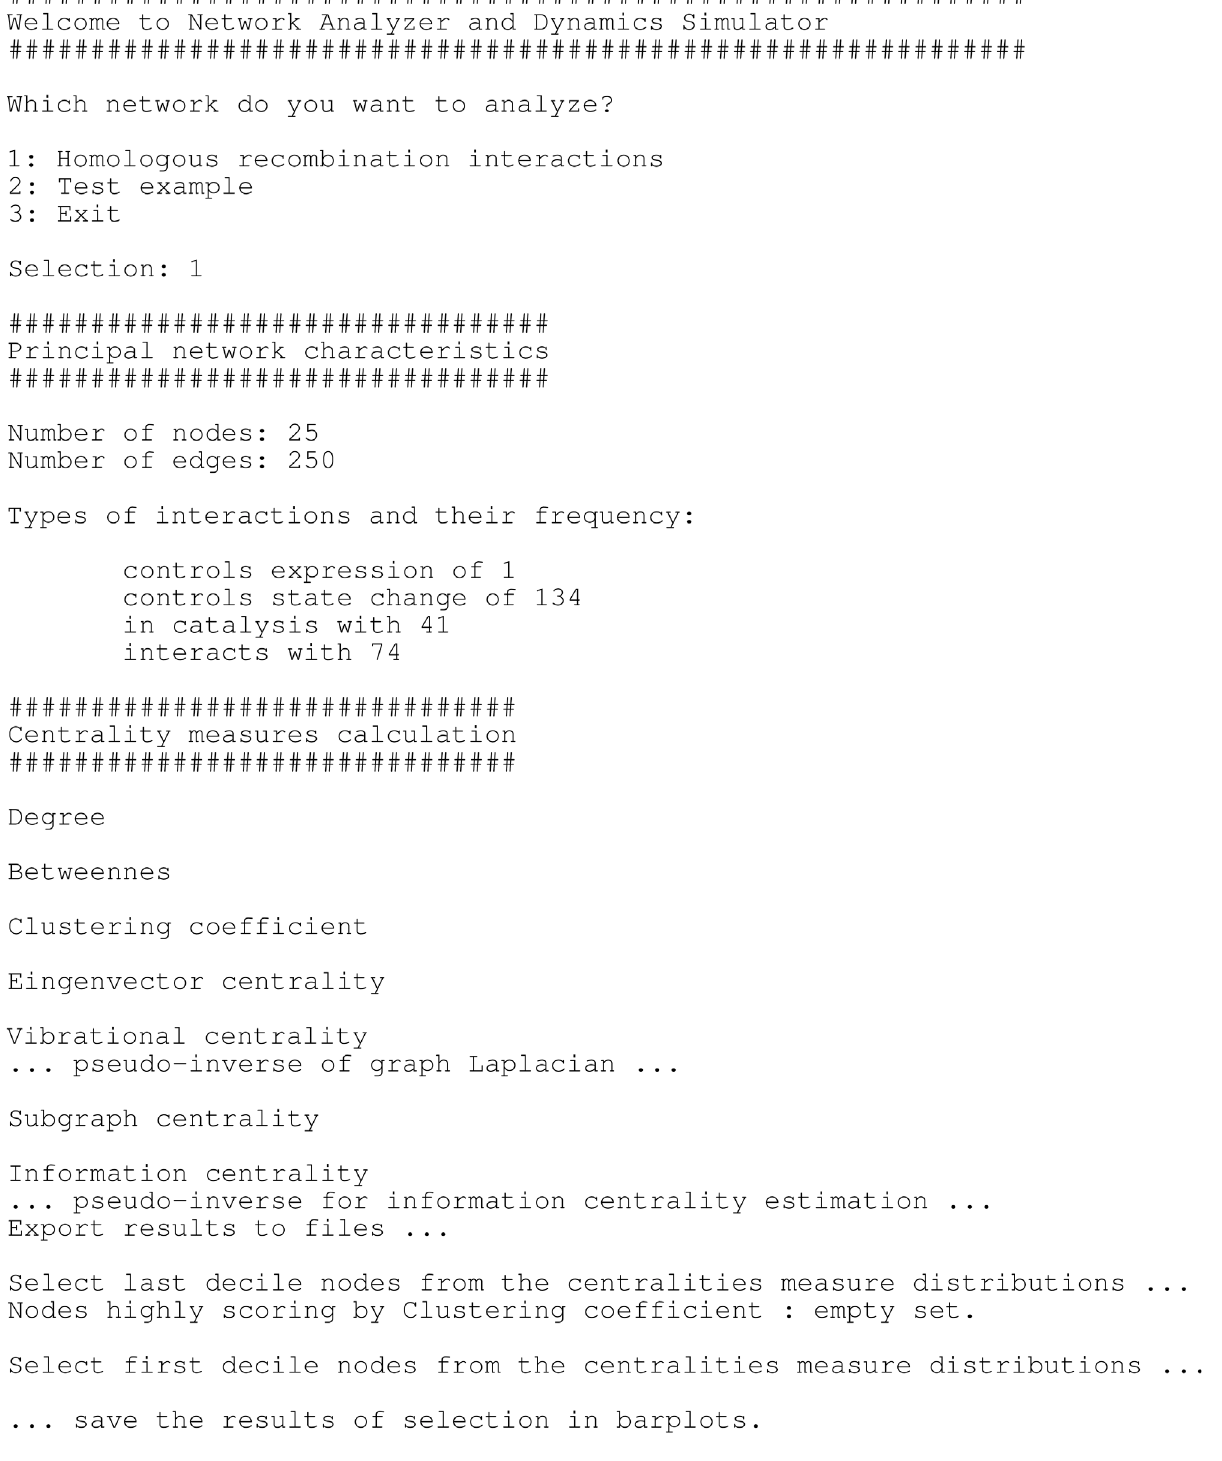
Frontiers in Molecular Biosciences |